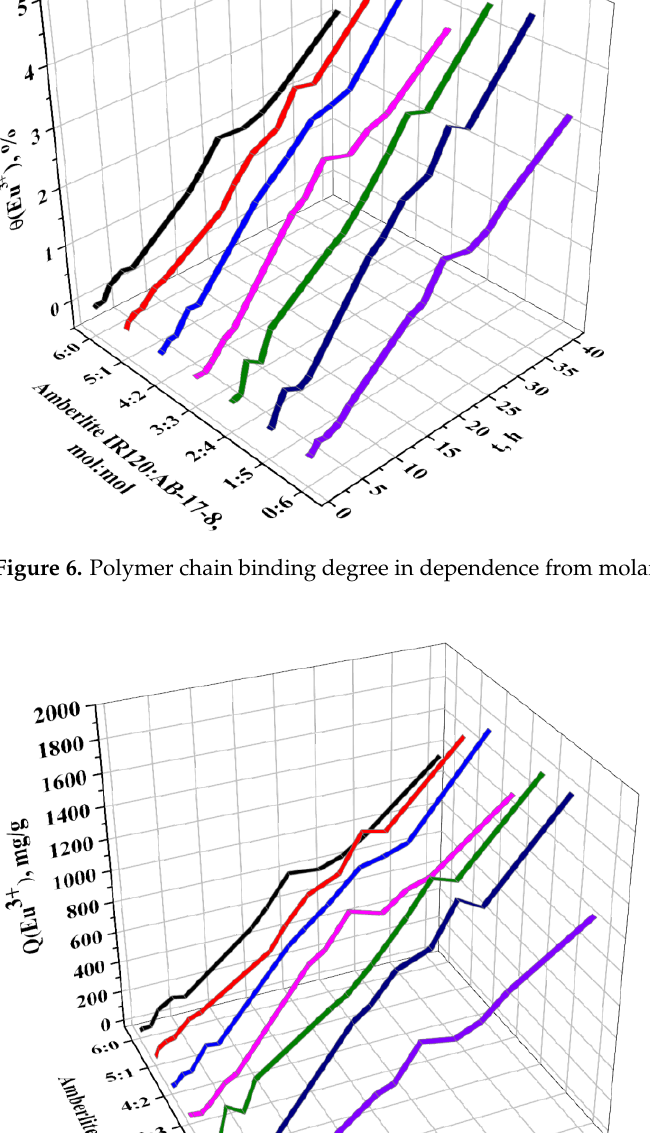
Figure 6. Polymer chain binding degree in dependence from molar ratios and time.